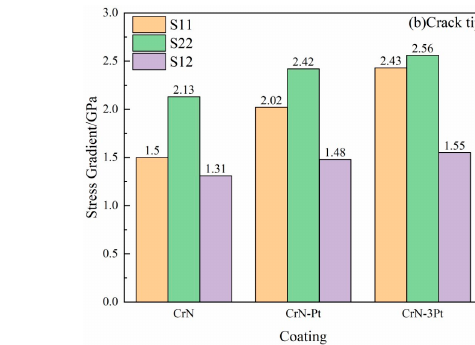
Figure 9. Isotropic stress gradients when cracks propagate to half the thickness of the three coatings. ( a ) Middle of crack; ( b ) Crack tip.